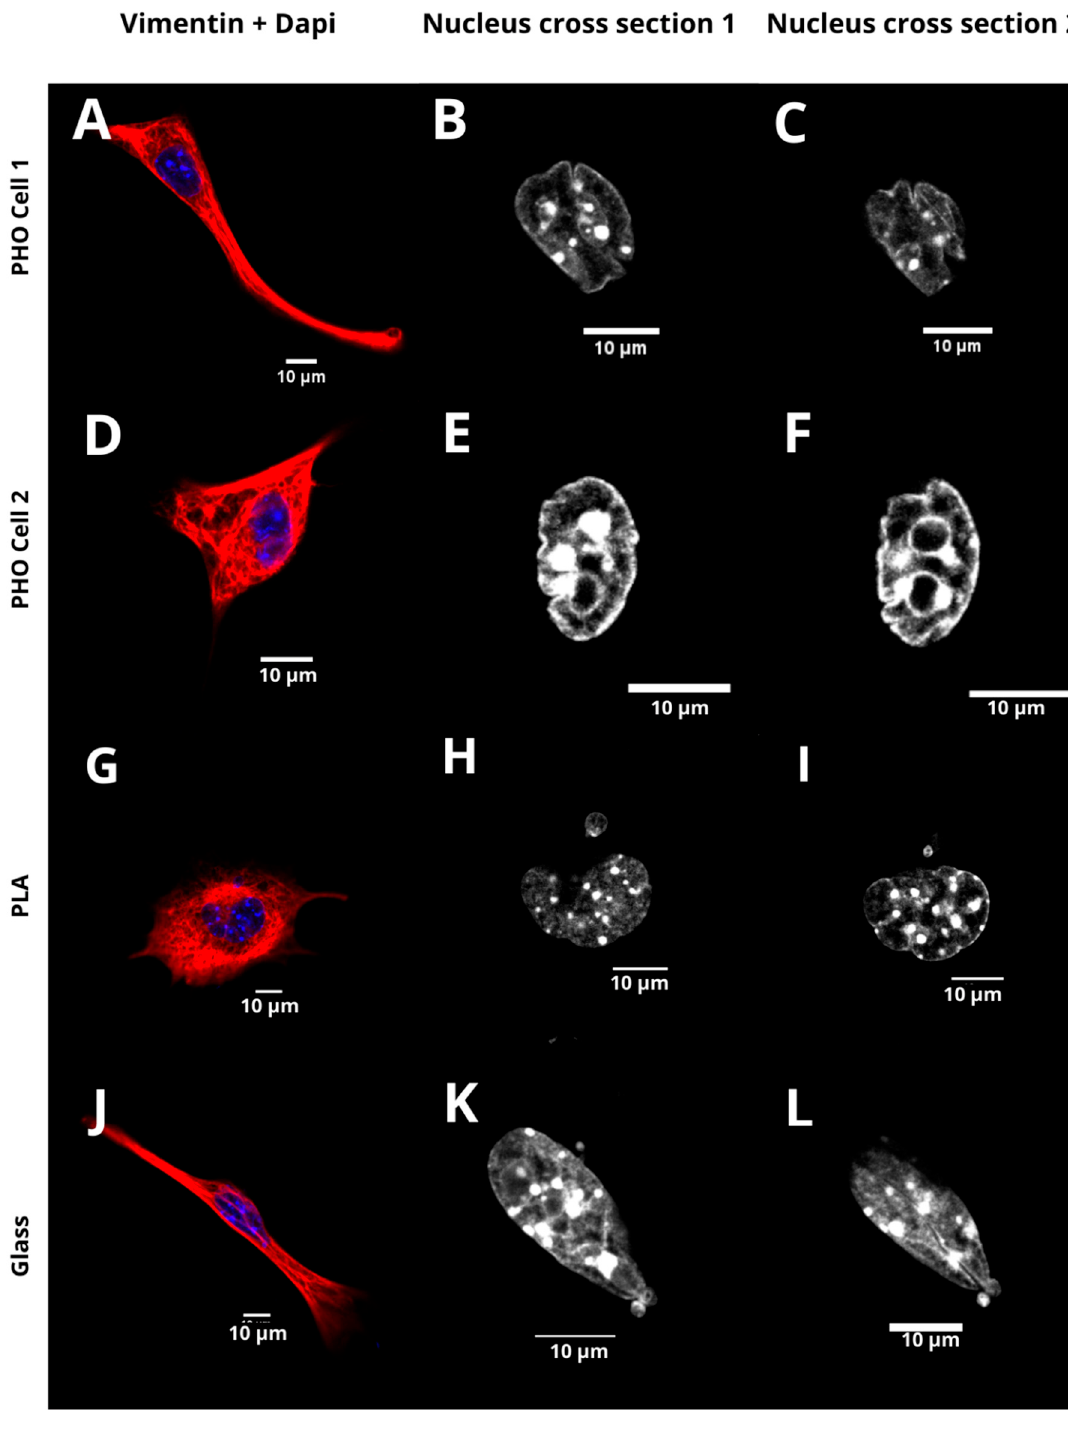
Figure 3. Examples of grooves and deformations of nuclei in MEF 3T3 cells cultured on glass ( J – L ), PHO (polyhydroxyoctanoate) ( A – F ), and PLA (polylactide) substrates ( G – I ). Two cross sections were selected for each nucleus.